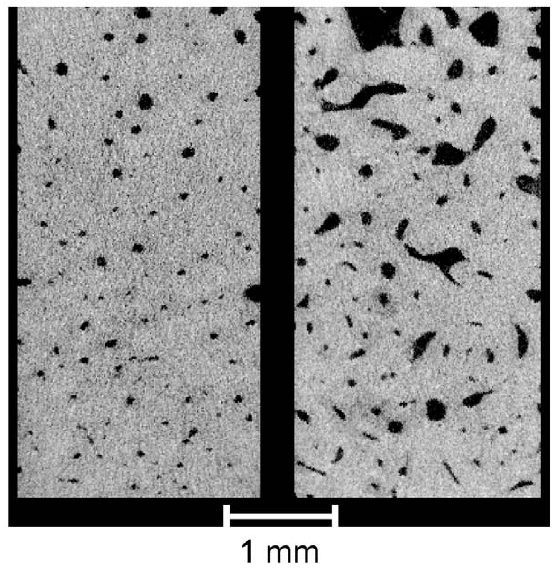
Figure 5. Axial m CT images are shown for cortical bone specimens from a 48 y.o. male donor (left) and an 82 y.o. male donor (right). For the 48 and 82 y.o. donors, respectively, avBMD was 1222 and 1135 mg-HA/cm 3 , and porosity was 4% and 11.3%.